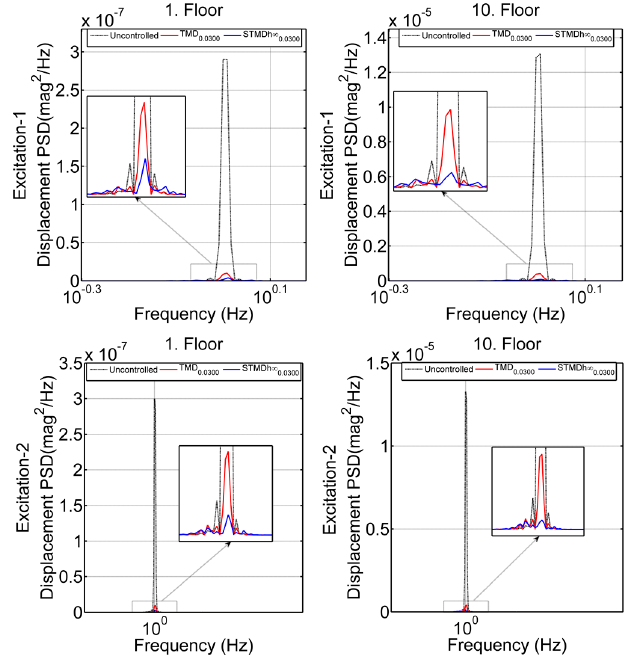
Figure 14. Displacement power spectrum density (PSD) curves of the system first (left) and 10th (right) floors under the Excitation-1 (top) and Excitation-2 forces (bottom).